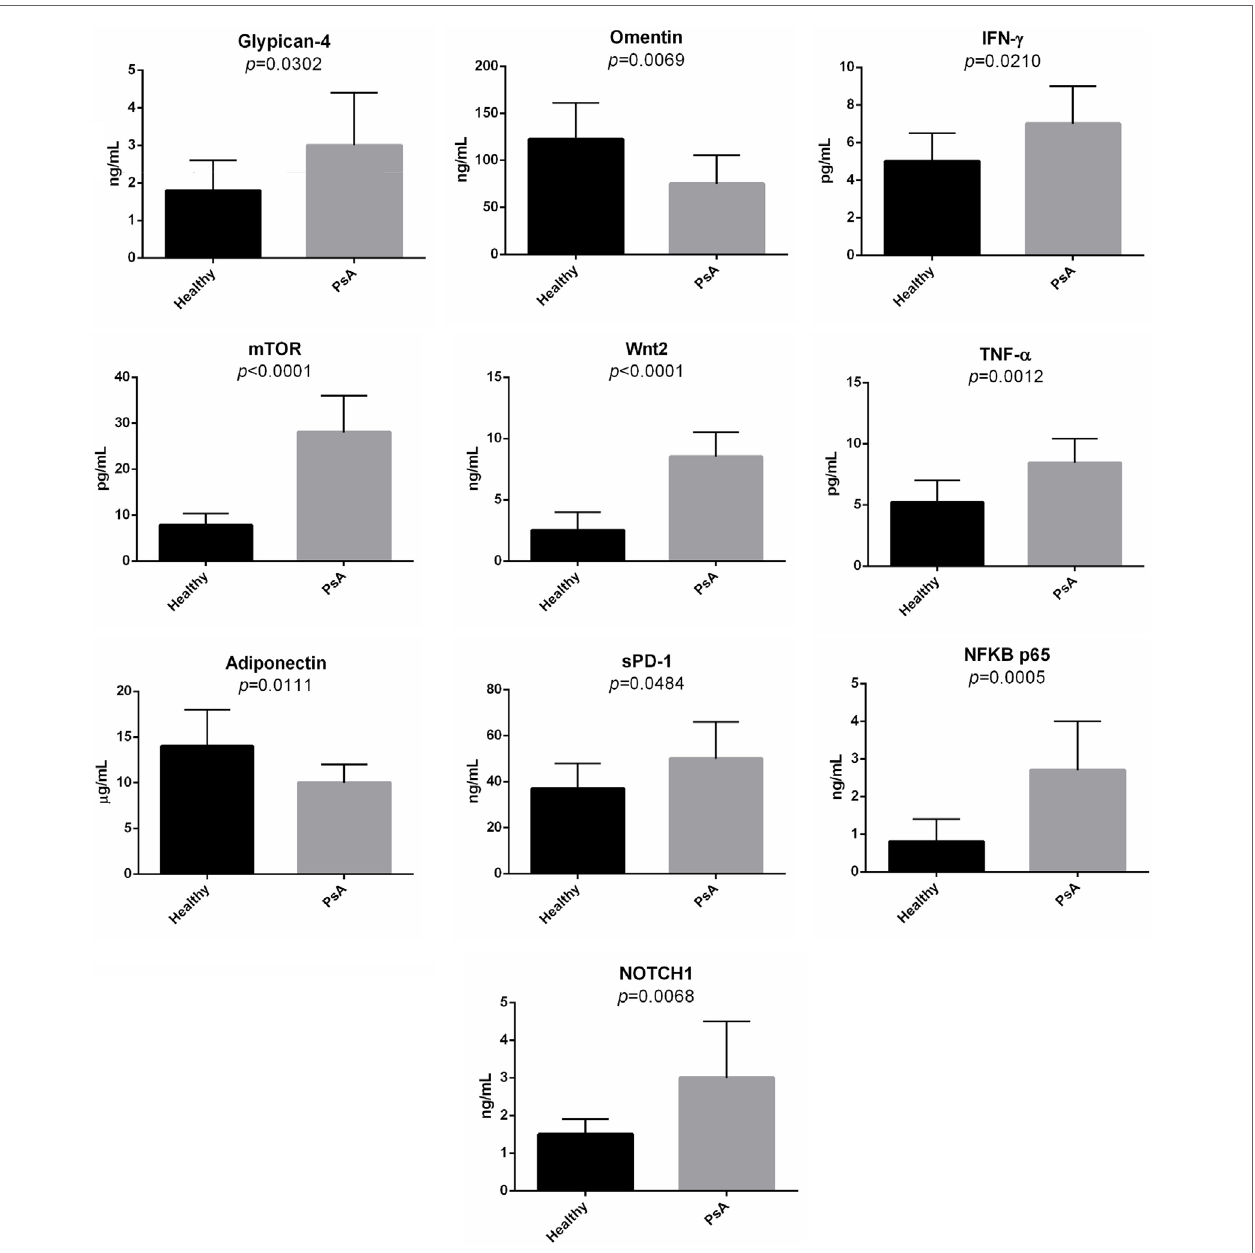
FigUre 7 | Serum levels of selected molecules in psoriatic arthritis (PsA) patients and in normal subjects. The histograms represent the mean of the results obtained in 20 healthy donors and in 20 PsA